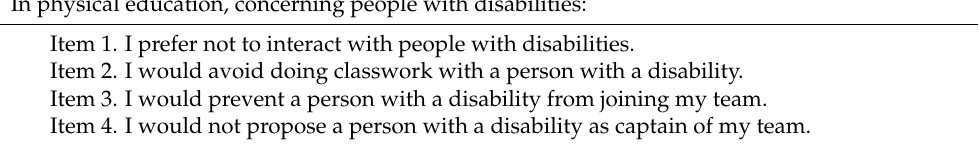
Table 2. The Scale of Attitudes toward Students with Disabilities in Physical Education–Primary Education